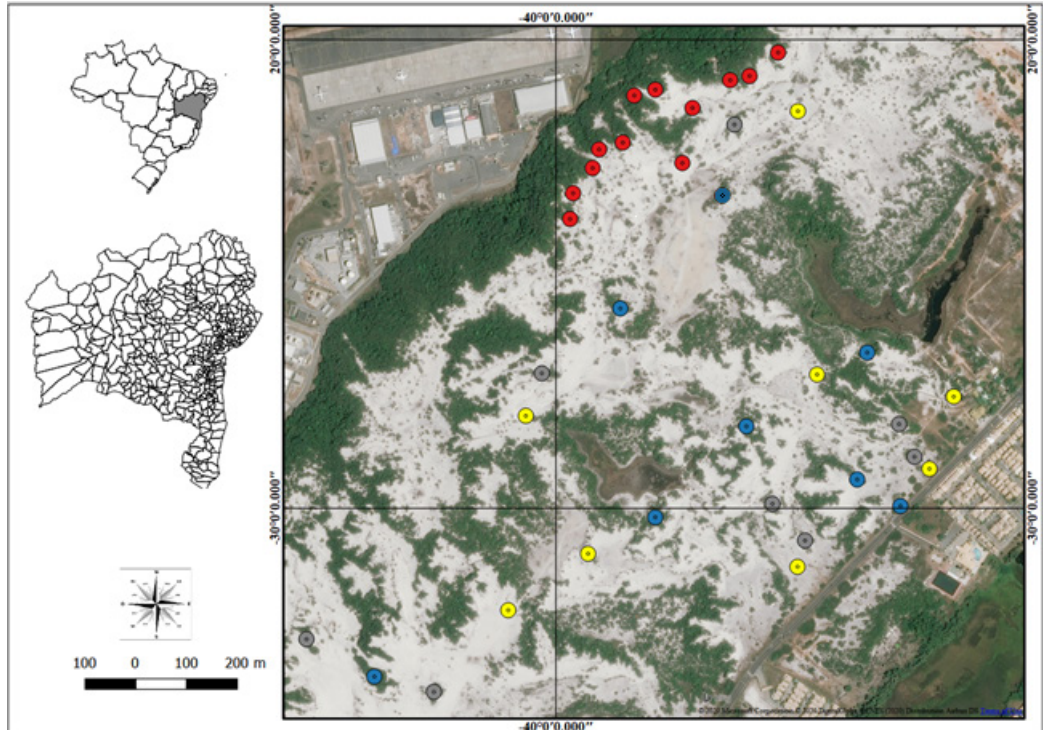
Fig 1 . Map of Parque das Dunas and their respective sample points. Yellow = small microhabitats; Gray = medium microhabitats, Blue = large microhabitats and red = continuous